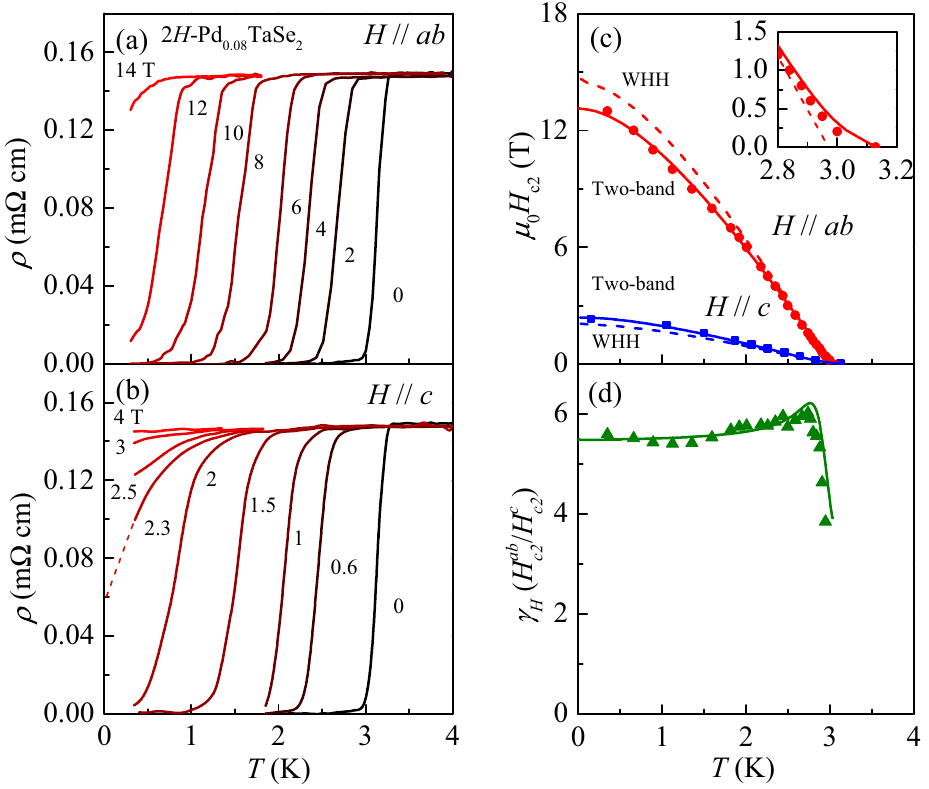
ab and ( b ) H c . The dashed line in ( b ) Figure 3. In-plane resistivity ρ of 2H-Pd 0.08 TaSe 2 crystal for ( a ) H (cid:31) (cid:31) shows a linear extrapolation of ρ( T ) to estimate the T c at µ 0 H = 2.3 T. ( c ) Temperature dependence of upper ab ( H ab H c ( H c critical fields for H c 2 ) and c 2 ). Also plotted are the best fit results based on the Werthamer– (cid:31) (cid:31) Helfand–Hohenberg (WHH) model (dashed lines) for a single-band superconductor and the two-band model ab T c . ( d ) The anisotropy (solid lines). The inset in ( c ) shows an enlarged view of the H c 2 and the fitting lines near H ab H c ratio γ H c 2 / c 2 is presented (green solid triangles), exhibiting strong temperature dependence. The solid = line is obtained from the fitting curves for the two-band model shown in ( c